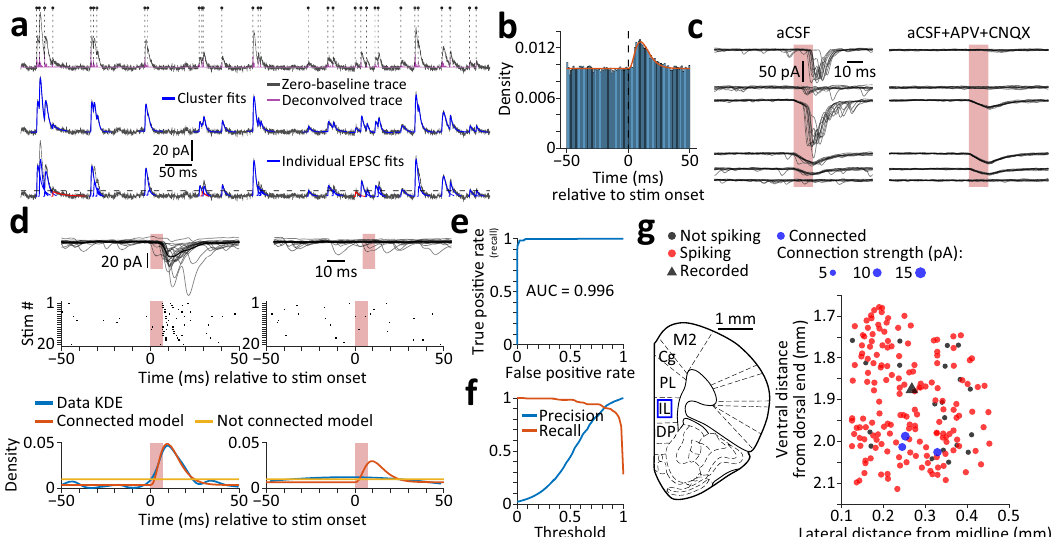
Fig. 2 | Analysis and modeling of synaptic connections. a , Detection and mod- eling of excitatory postsynaptic currents (EPSCs) in continuous voltage-clamp recording traces obtained during stimulation of candidate presynaptic cells. Top, The zero-baseline version of the inverted recording trace (gray) was deconvolved with a synaptic-event waveform kernel using OASIS (purple trace). Putative EPSCs were detected based on peaks in the deconvolved trace. Dots and vertical dashed lines mark the fi ttedonsettimesof detected events (see Bottom).Middle,Putative events were then clustered by temporal proximity, and each cluster was fi t with a model which assumes linear summation of EPSCs (blue traces). Bottom, Clustered events were decomposed and their kinetic features were extracted. EPSCs with amplitude below a 2.5 c SD threshold (dashed line) were discarded (red traces). b Peristimulus time histogram of EPSCs ( n = 151797 EPSCs recorded during sti- mulationof n =10445cells,binsize= 1ms),overlaid witha fi tted mixturemodelof gammaanduniformdistributions.Parameter fi ts[95%con fi denceinterval]:Gamma shape k =4.1896[3.7063,4.6729];gammascale θ =3.0942[2.6602,3.5283];weight w = 0.0455 [0.0421, 0.0489]. Only stimulated cells that did not evoke any direct photocurrent in the recorded cell were considered for thisdistribution. c Example traces obtained during stimulation of six mPFC-BLA cells while recording from another mPFC-BLA cell (left), and during repeated stimulation in the presence of